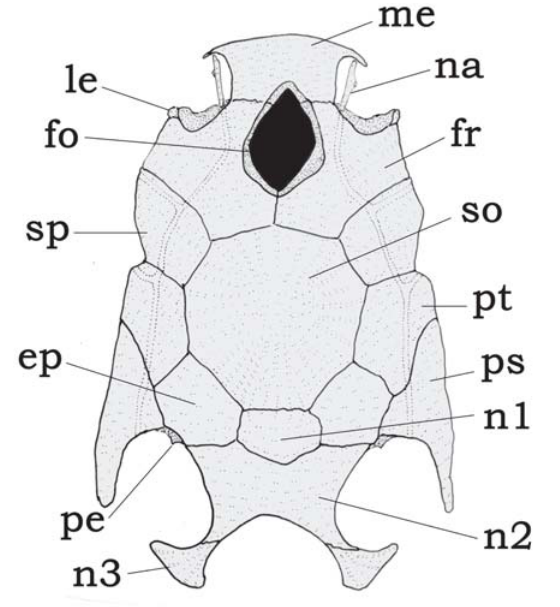
Fig. 17. Neurocranium of Tatia caxiuanensis , new species, MPEG 6201, 29.3 mm SL. Dorsal view. Abbreviations: ep , epioccipital; fo , single cranial fontanel, fr , frontal; le , lateral ethmoid; me , mesethmoid; na , nasal; n1 , first nuchal plate, n2 ; second nuchal plate; n3 , third nuchal plate; pe , posterior epioccipital process; ps , posttemporal-supracleithrum; pt , pterotic; so , supraoccipital; sp , sphenotic. Scale bar = 1 mm.